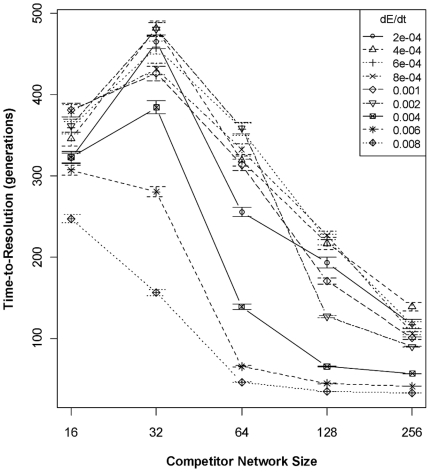
Effect (± 95% CI) of competitor's genetic architecture
and the rate of environmental change (dE/dt) on the duration of
competition.The time required for one of the two competing species to go to dominance
(i.e., drive the other species extinct) in a single patch is largely a
function of the relative difference in network sizes and the rate of
environmental change (dE/dt). The focal species' genetic architecture
is held constant (as in Figure
1) while the competitor species' genetic architecture
varies. Time-to-resolution is the number of generations
between the start of competition and the generation in which one species has
gone extinct. Resolution occurs quickly when dE/dt is high—we quickly
find that one species is not suited to the environment—whereas
resolution takes considerably longer when dE/dt is low. Likewise, as the
disparity between each species underlying network increases, the
time-to-resolution declines. The lower persistence time for 16-gene network
competitors is a result of the recombination rate treatment (see Methods).